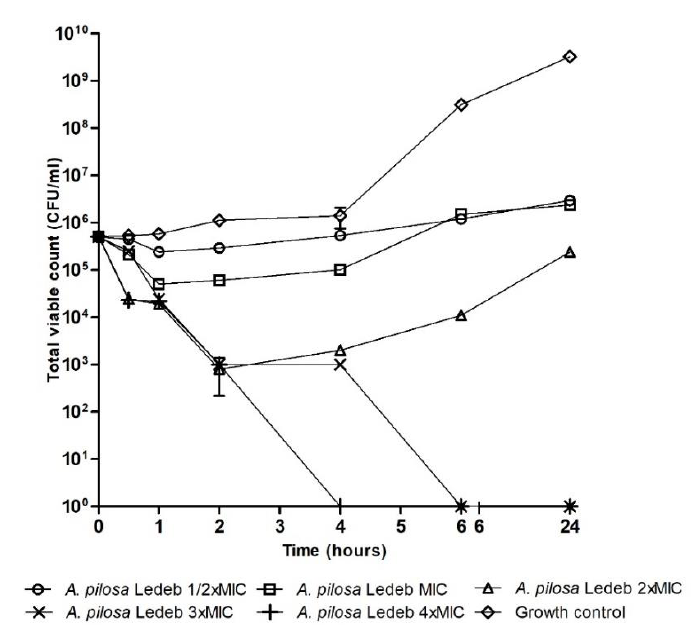
Figure 1. Total viable count of endogenous and inoculated Listeria monocytogenes QA1018, LS12519, and CP102 mixture in the presence of Agrimonia pilosa Ledeb.